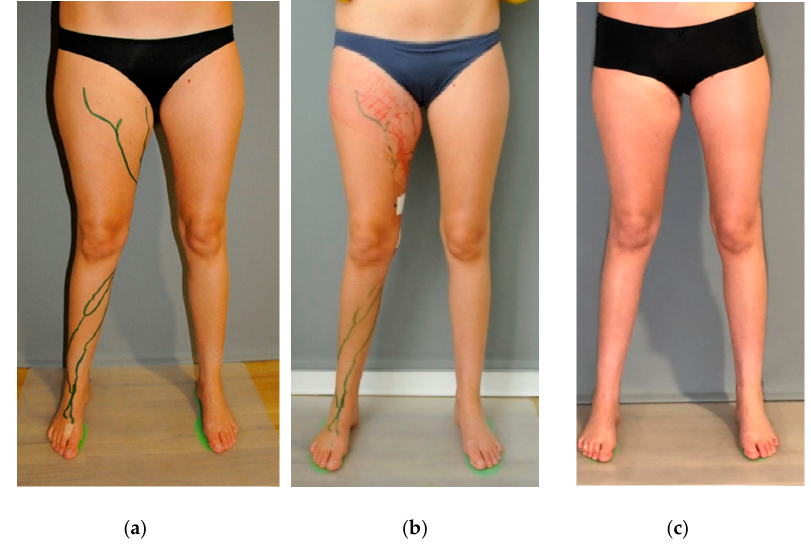
Figure 1. A young woman with a lymphatic malformation at the right thigh. ( a ) Preoperative status ( b ) Immediate postoperative status. Note the considerable decrease in volume of the right thigh. ( c ) Clinical outcome 4 months